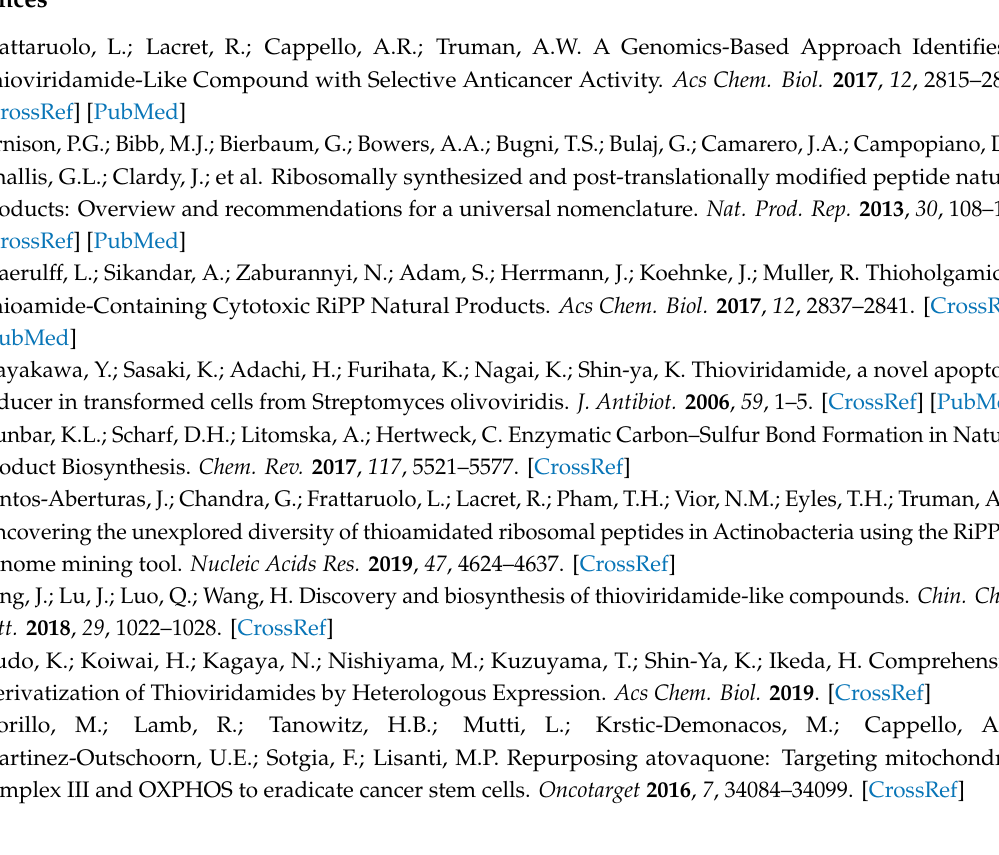
s1: Figure S1: Thioalbamide a ff ects breast cancer cellular growth; Figure S2: Thioalbamide-induced DNA fragmentation in MDA-MB-468 cells; Figure S3: Thioalbamide-induced DNA fragmentation in SKBR3 cells; Figure S4: Thioalbamide-induced DNA fragmentation in T47D cells; Figure S5: Thioalbamide-induced DNA fragmentation in MDA-MB-231 cells; Figure S6: Thioalbamide induces apoptosis in breast cancer cell lines; Figure S7: Oxidative stress underlies thioalbamide cytotoxicity in breast cancer cell lines; Figure S8: Metabolic profile of breast cancer cells treated with thioalbamide; Figure S9: Thioalbamide induces loss of mitochondrial membrane potential in breast cancer cells; Figure S10: Thioalbamide reduces CD44 expression in breast cancer